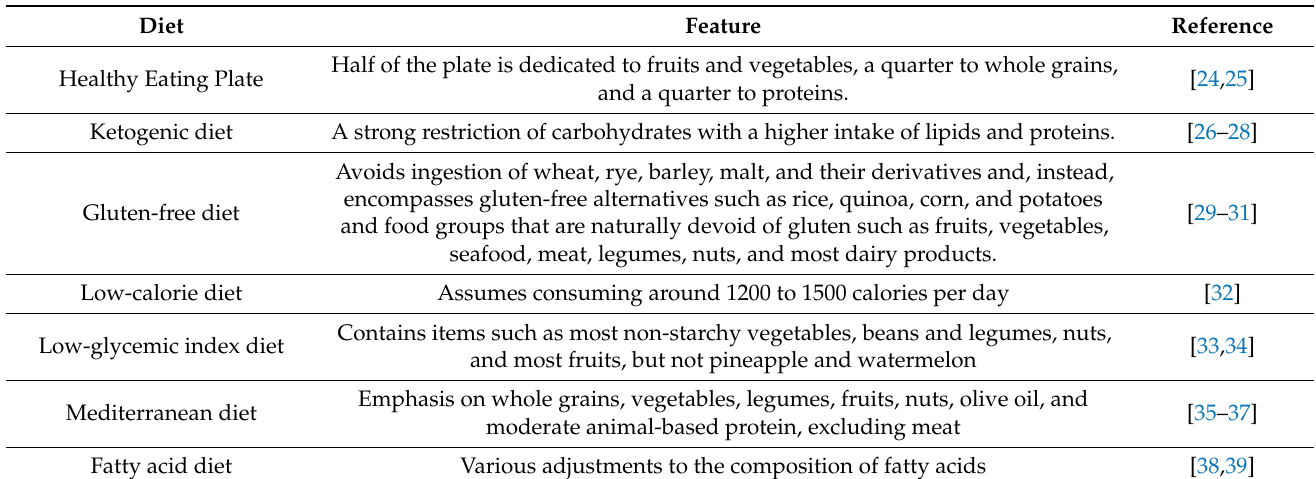
Table 1. Some diets that are reported to have beneficiary effects in migraine prevention and treatment with some exemplary